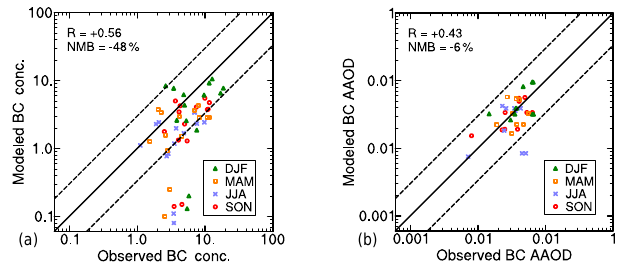
Figure 3. Comparisons of observed and modeled seasonal mean (a) near-surface concentrations (units: µgm − 3 ) and (b) aerosol ab- sorption optical depth (AAOD) of BC in China. Solid lines mark the 1 : 1 ratios, and dashed lines mark the 1 : 3 and 3 : 1 ratios. Ob- served BC concentrations were taken between 2006 and 2007 at 14 sites of the China Meteorological Administration (CMA) At- mosphere Watch Network (CAWNET) (Zhang et al., 2012). Ob- served AAOD of BC is obtained by removing dust AAOD from to- tal AAOD at 10 sites of the Aerosol Robotic Network (AERONET) (Holben et al., 2001), following Bond et al. (2013). The observed AAOD are averaged over 2005–2014 where data are available. Cor- relation coefficient ( R ) and normalized mean bias (NMB) between observation and simulation are shown at the top left of each panel. NMB = 100% × P (M i − O i )/ P O i , where M i and O i are the modeled and observed values at site i , respectively. Site locations are shown in Fig.